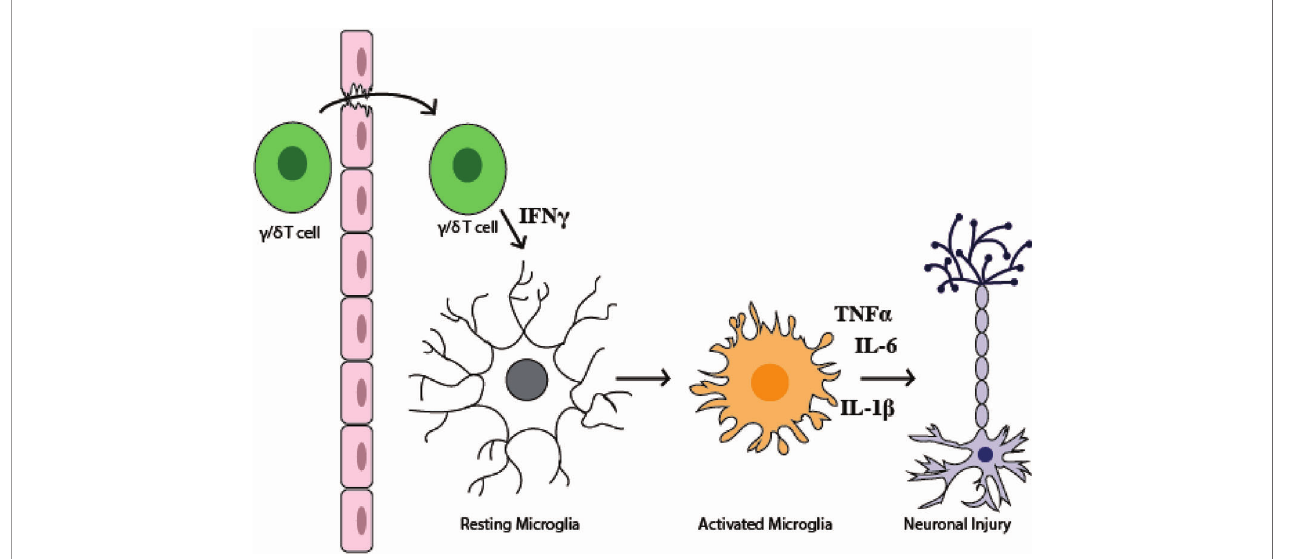
FIGURE 10 | Model fi gure of the mechanism of fetal brain injury in the setting of intrauterine in fl ammation. This model demonstrates how g / d T cells in the fetal brain may lead to fetal brain injury. This model re fl ects both data in this paper and data from previously published literature that demonstrate that (1) the fetal blood brain barrier is weakened by maternal in fl ammation (2), during systemic in fl ammation g / d T cells may traf fi c to the brain (3), an increase in IFN g + g / d T cells are present in the fetal brain following IUI (4), IFN g leads to microglial activation, and (5) prenatal microglial activation can cause neuronal